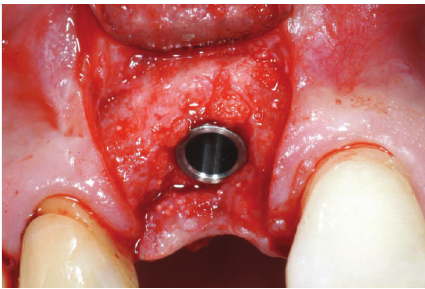
Figure 13: The 4.1 × 12 mm Morse taper connection implant immediately after placement in the regenerated